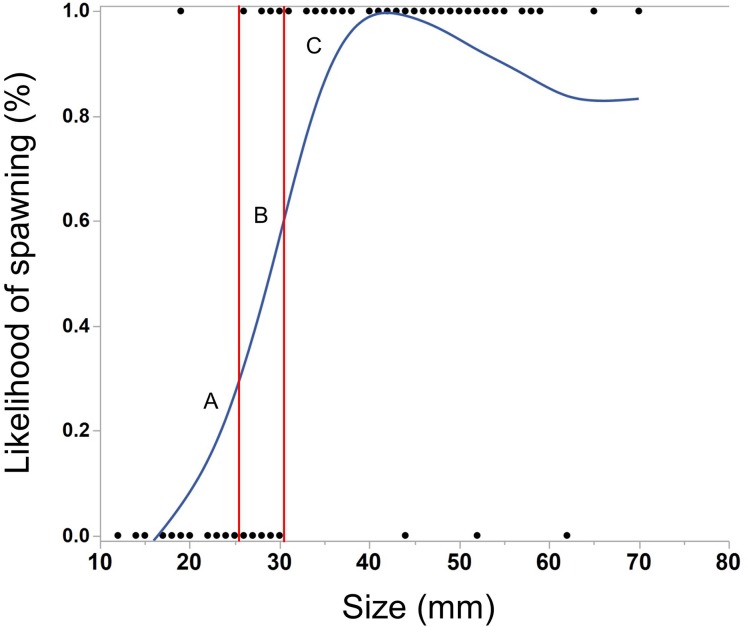
Cubic spline showing the effect of body size of M. leidyi on the likelihood to spawn.Points along the lower x-axis indicate individuals that did not spawn, while points on the upper x-axis indicate individuals that did spawn. Multiple individuals of the same size may be represented by a single point. Ctenophores smaller than 26 mm (section A) rarely spawned (1/22 = 5%) while those larger than 30 mm (section C) almost always spawned (77/80 = 96%). Nearly half of the individuals between 26 and 30 mm spawned (section B, 6/16 = 38%). Lambda value of cubic spline set to 1.